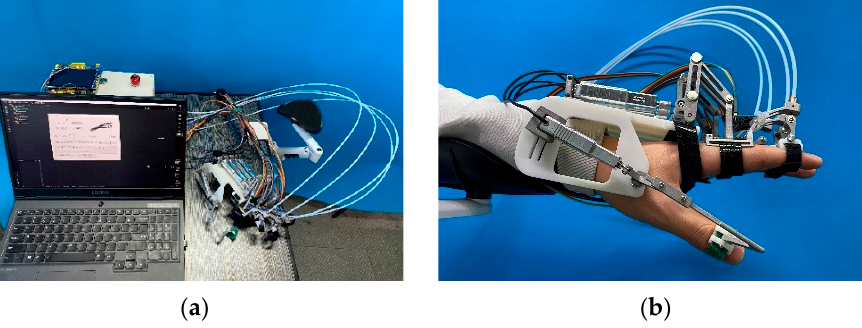
Figure 12. The ( a ) overview of the experimental platform and ( b ) the prototype of the hand rehabilitation robot.